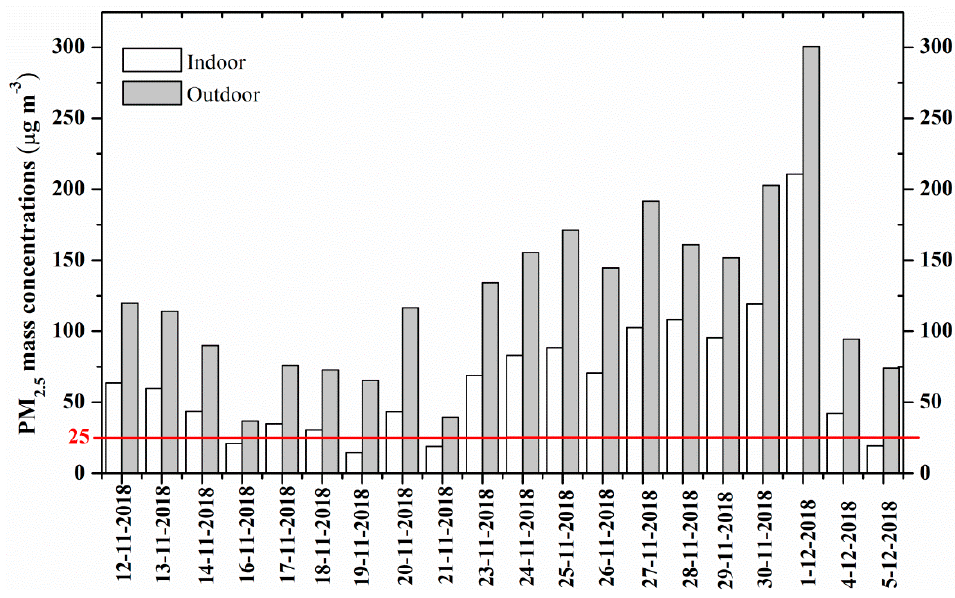
Figure 2. Time series of indoor and outdoor PM 2.5 mass concentrations. Table 1. Statistics of indoor and outdoor PM 2.5 and chemical components ( µ g m − 3 ). Indoor